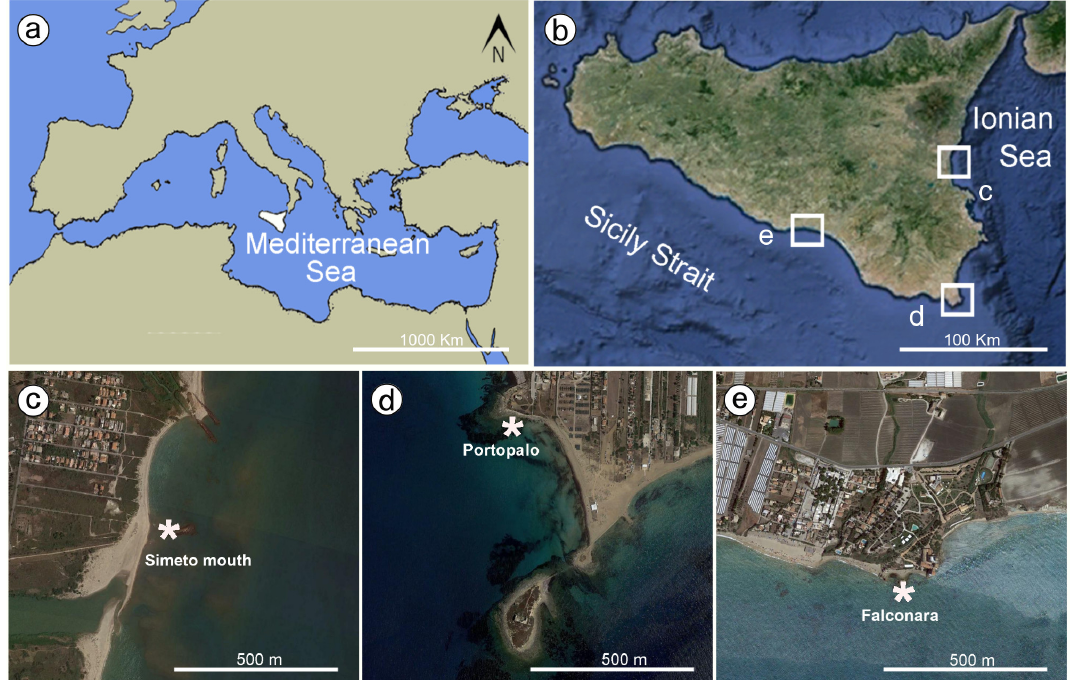
Figure 1Figure 1. ( a , b ) Study areas (white squares) in the Mediterranean Sea, with the locations of the S. alveolata on the Sicilian coasts: ( c ) Simeto mouth, ( d ) Portopalo, and ( e ) Falconara. The maps ( c – e ) are from Google Earth. Asterisks indicate sampling